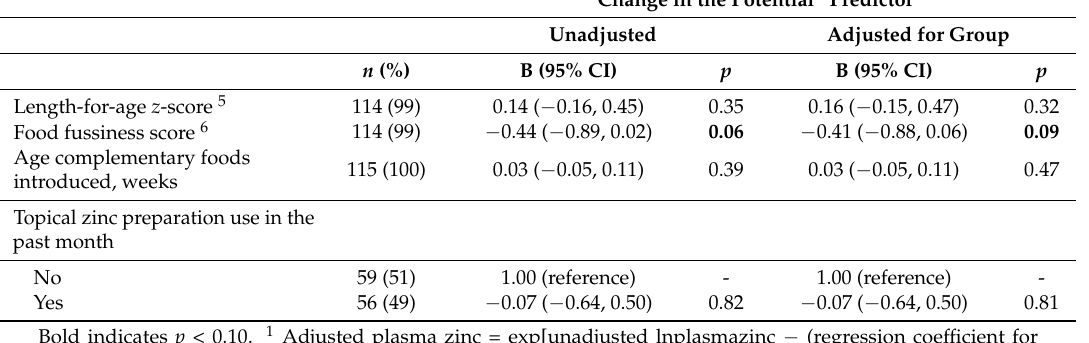
Table 3. Cont. Change in Plasma Zinc Concentration ( µ mol/L) 1 for Each Unit